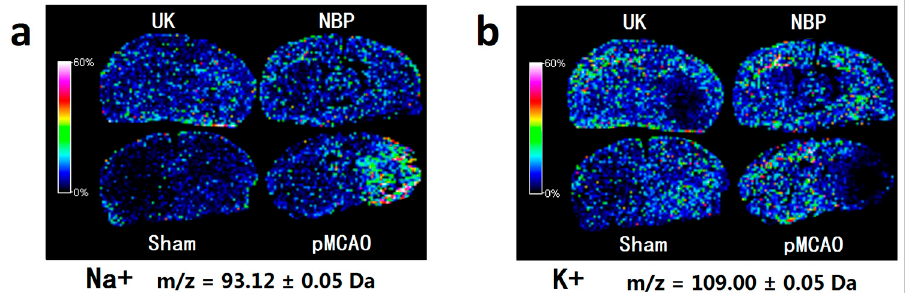
Figure 8. Dl-3-n-butylphthalide improved the balance of metal ions. MALDI-TOF-MS imaging of ( a ) Na + and ( b ) K + . The spatial resolution was set to 200 µm. m/z : mass-to-charge ratio. Scale bar = 5 mm.